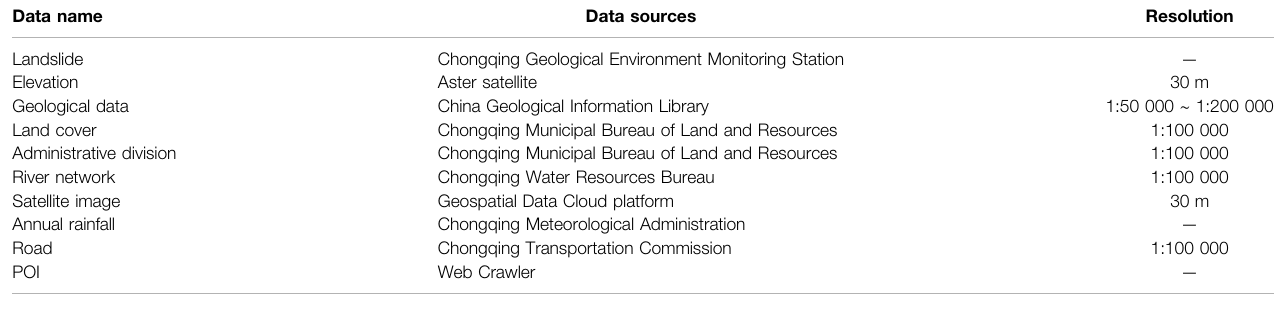
TABLE 1 | Data and data sources.